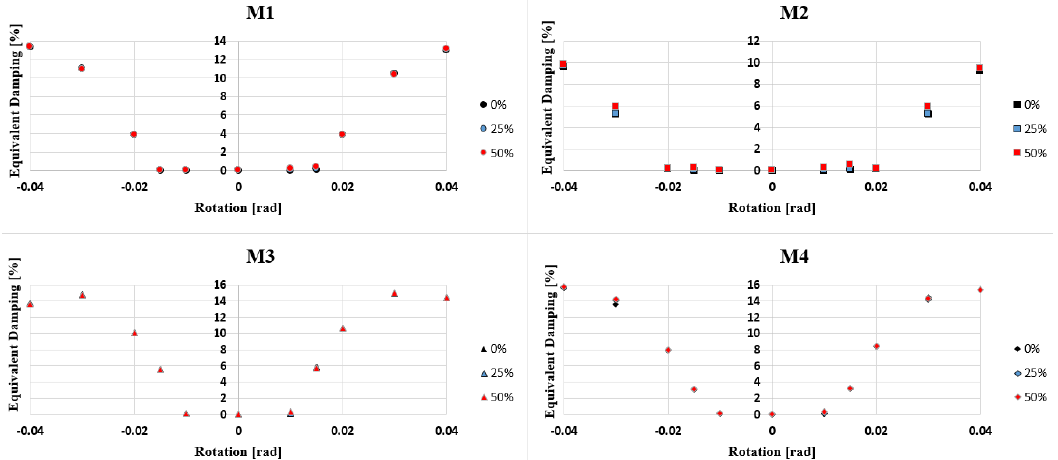
Figure 10. Equivalent damping vs. rotation for the configurations studied.